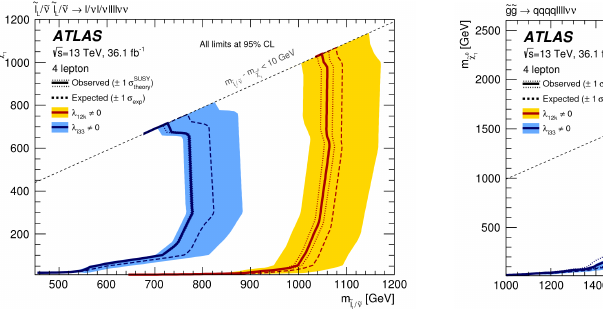
Figure 23: RPV wino W / Z NLSP [ 21 ] . Figure 24: RPV wino W / h NLSP [ 21 ] .